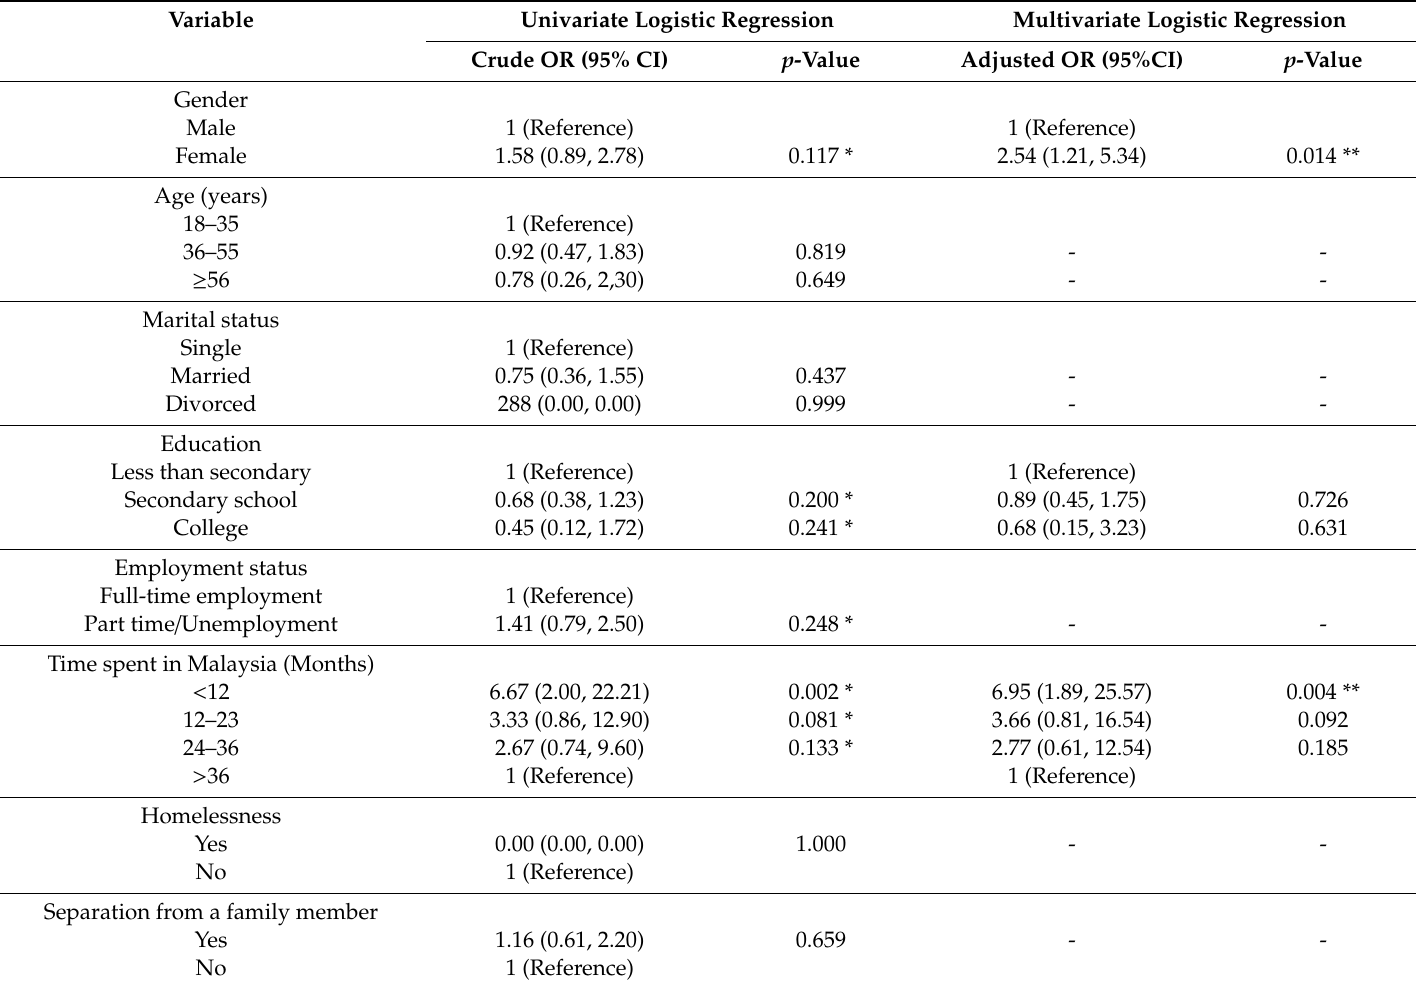
Table 3. Univariate and multivariate logistic regression for variables associated with major depressive disorder (MDD).